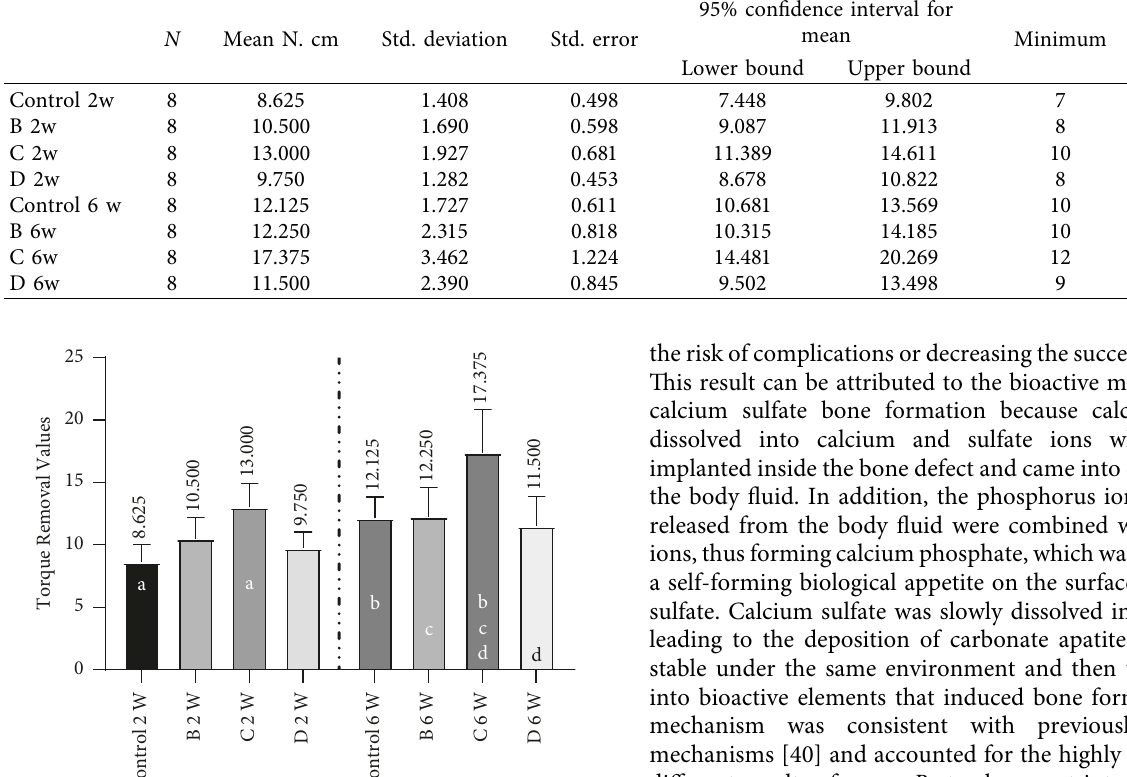
Figure 7: Bar chart with a mean and standard deviation for the torque removal test after 2 to 6 weeks of healing. Groups with a similar lower case letter considered significance at p < 0 . 05 using Wilcoxon ranked